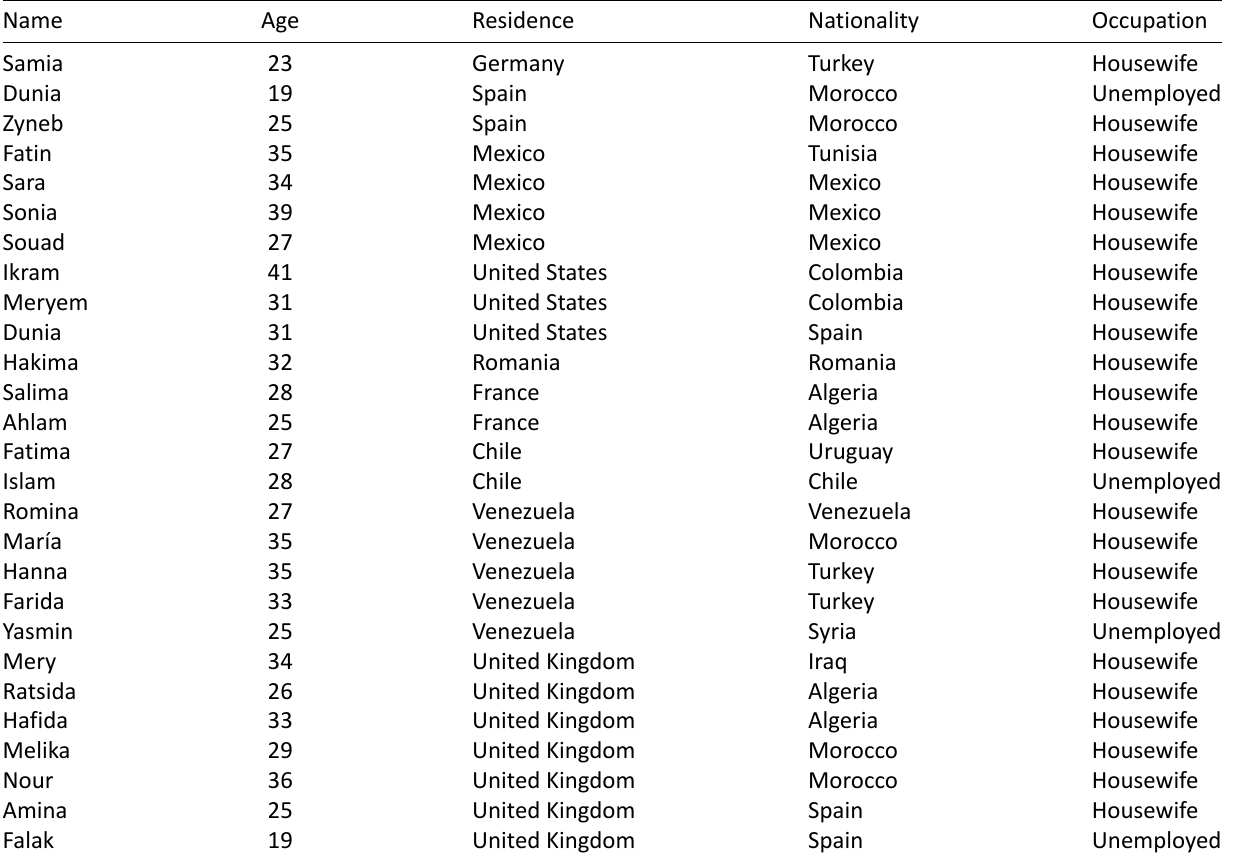
Table 1. Profiles of the interviewees (all names have been changed at the request of the women participating in the